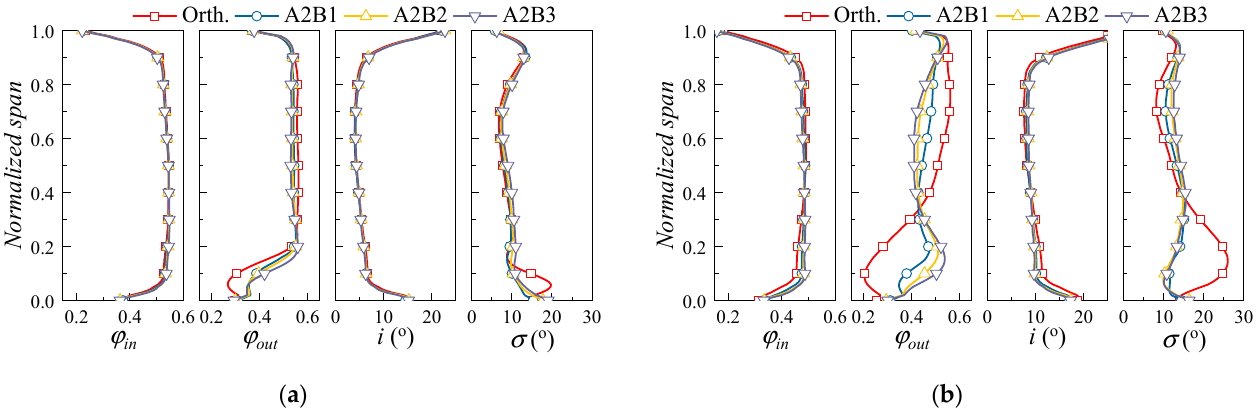
Figure 12. Radial distribution of aerodynamic performance for the cases with different sweep angles. ( a ) φ = 0.52; ( b ) φ = 0.46. Figure 13 presents the variation of the mass flow rate for the stator leakage flow along the streamwise direction. Increasing the sweep angle tends to reduce the leakage flow at the blade leading edge, yet it will enhance the leakage flow in the other regions. The total mass flow rate of the leakage flow will be increased upon the utilization of the forward sweep, thus strengthening the interaction of different corner flow structures.